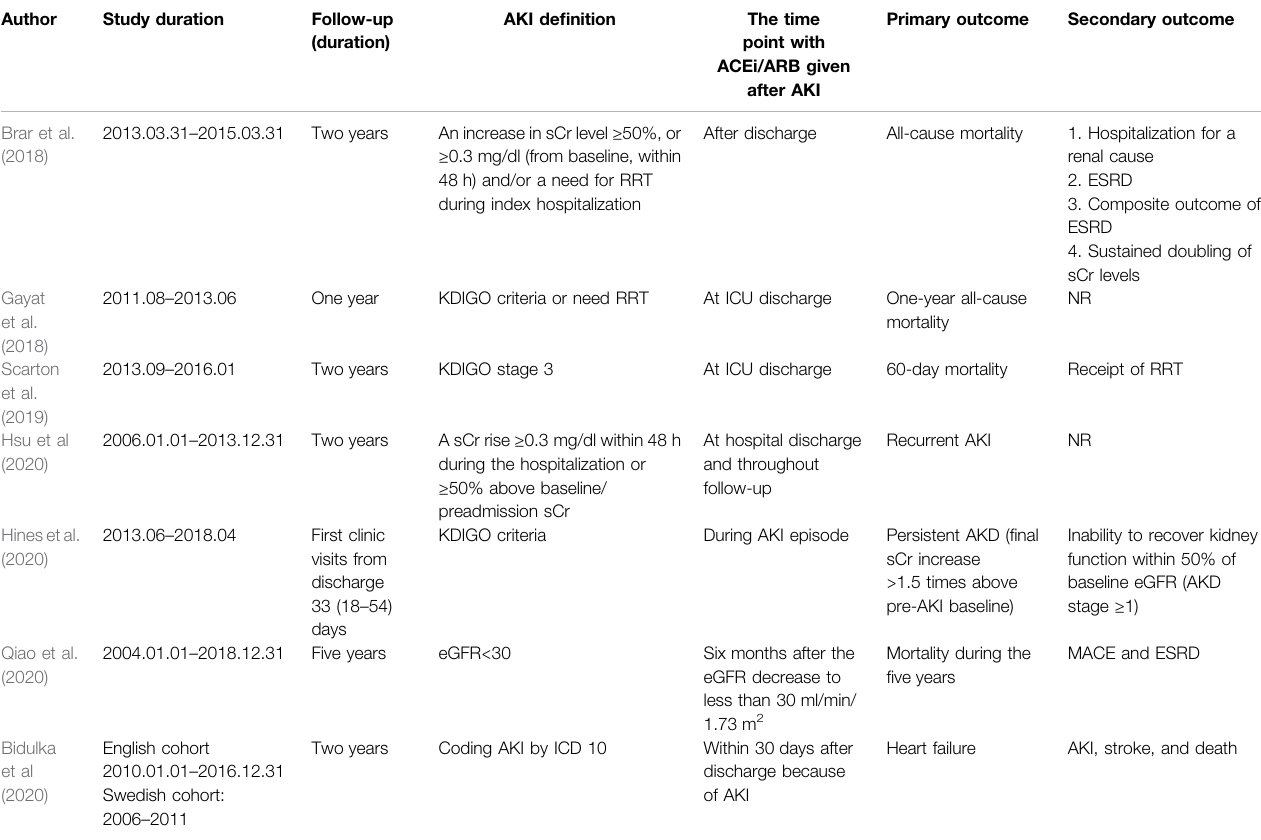
TABLE 2 | Summary of included comparative studies for outcome